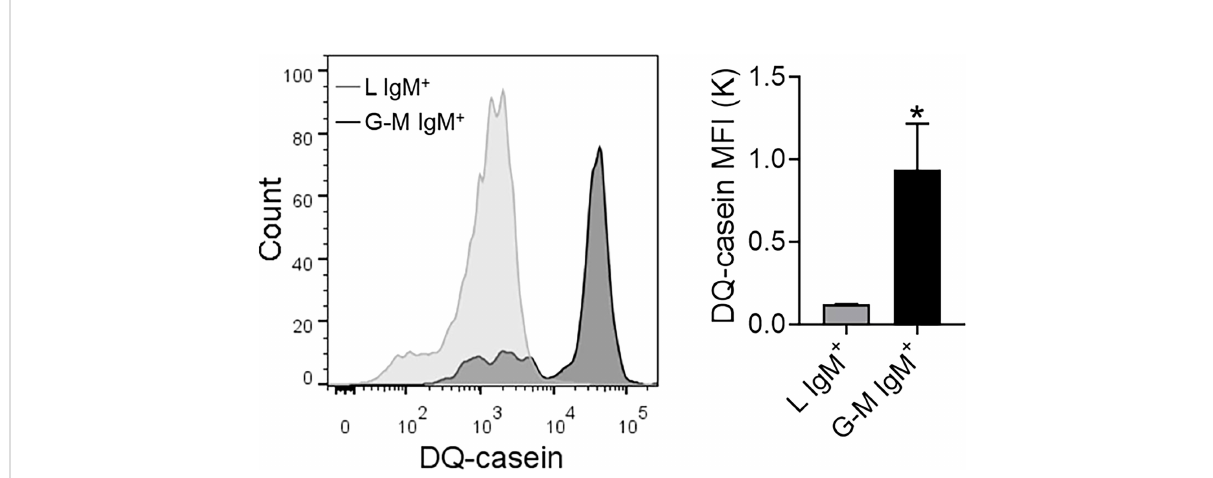
FIGURE 7 Antigen-processing capacity of L-gate and G-M gate IgM + cells. Nile tilapia anterior kidney (AK) leukocytes were incubated with DQ-casein (5 m g/ml) for 1 h at room temperature (RT) then labeled with an anti-tilapia IgM mAb and analyzed by fl ow cytometry. IgM + cells in the L and G- M gates were sorted and the signal intensity was quanti fi ed. Representative histograms are shown on the left panel, and the DQ-casein mean fl uorescence intensity (MFI) from different individual fi sh ( n = 3 fi sh) is shown in the right panel. Asterisks indicate signi fi cant differences (* p ≤